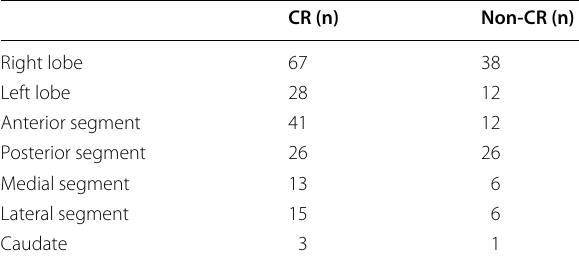
Table 4 Response to TACE classified by lobes and